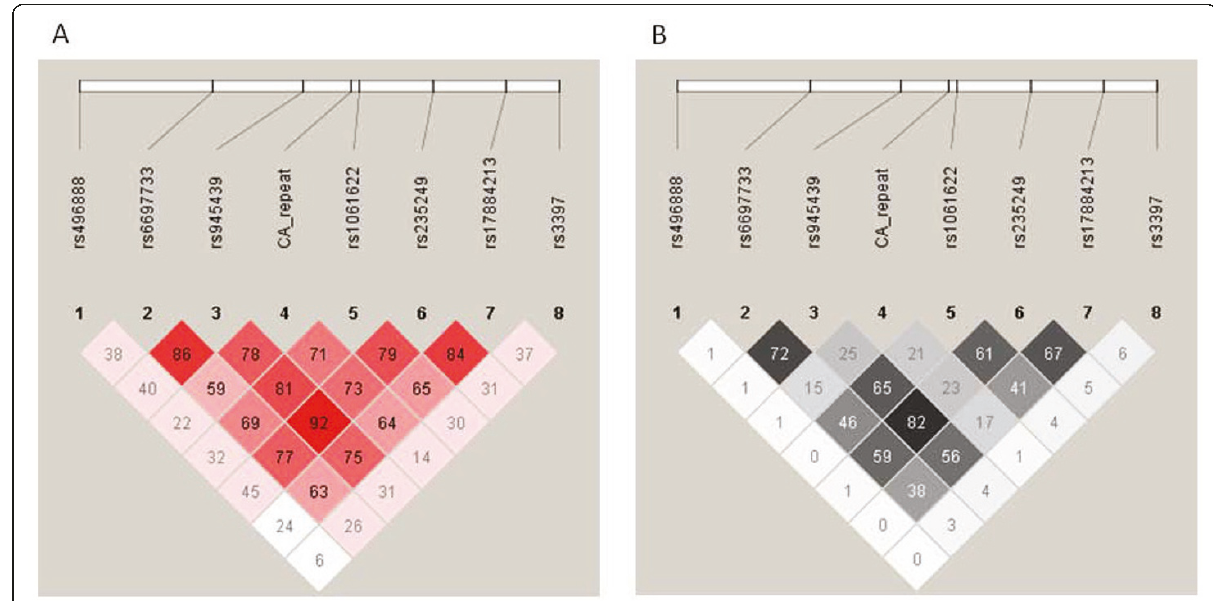
Figure 1 Pairwise linkage disequilibrium between the selected SNPs in TNFRSF1B . (A) Plot with D ’ values; (B) Plot with r 2 values between the SNPs.